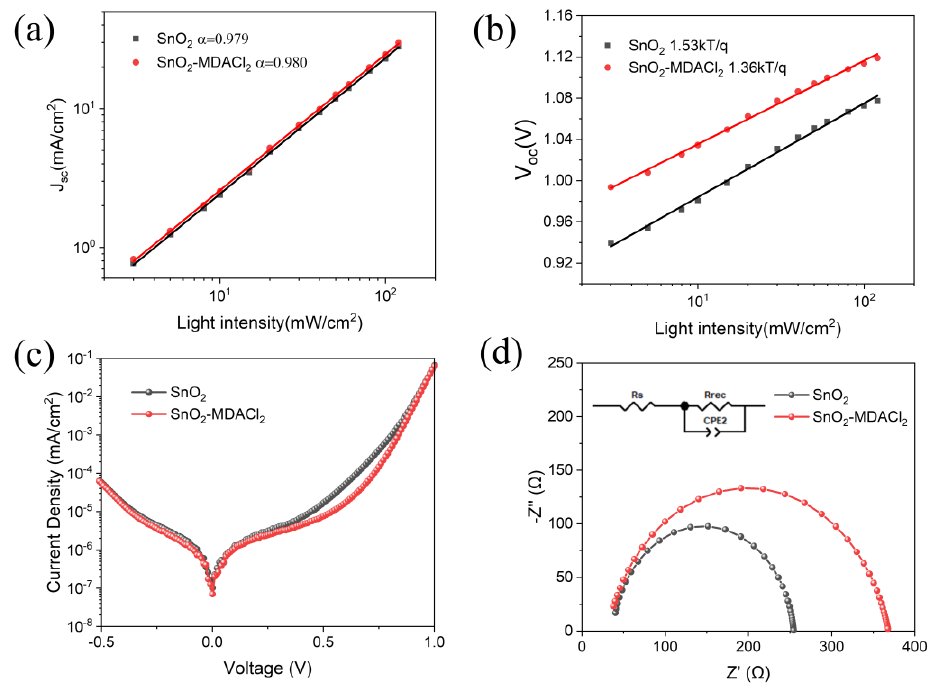
Figure 6. ( a , b ) Light intensity dependence characterizations of J SC and V OC for PSCs based on the SnO 2 and SnO 2 -MDACl 2 ETLs. ( c ) Dark-state J–V curves of the PSCs. ( d ) Nyquist plots for the PSCs (measured in dark conditions).